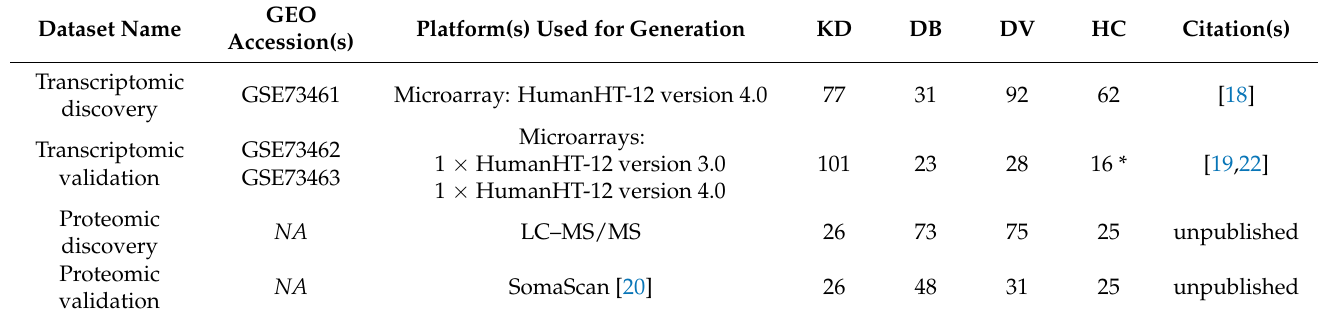
Table 1. The datasets used in the analysis. KD, DB, DV and HC are abbreviations for Kawasaki disease, definite bacterial, definite viral, and healthy control, respectively. LC–MS/MS is an abbreviation for liquid chromatography with tandem mass spectrometry. * = not used in